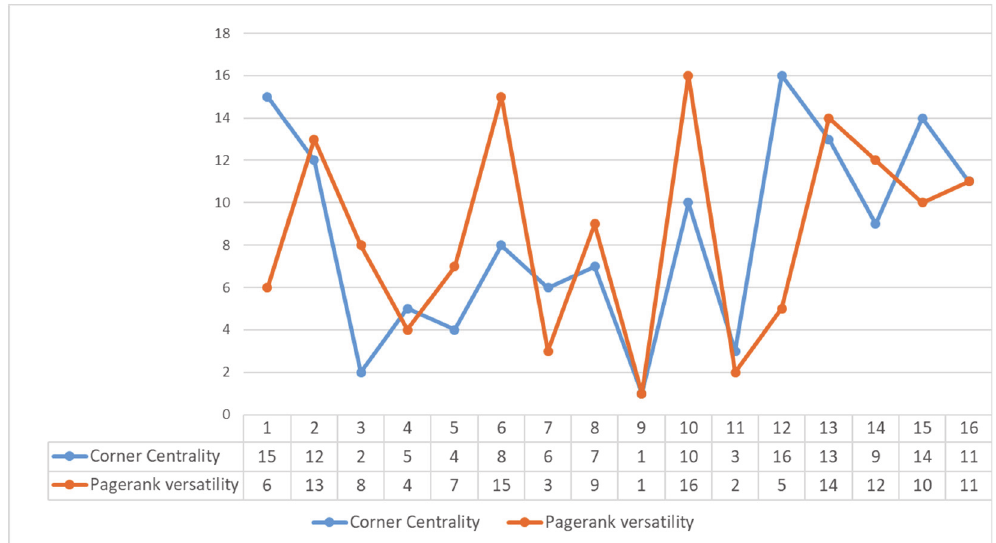
Figure 4. Comparison between Pagerank versality ranking and corner centrality ranking for the Florentine Families multiplex network. In this comparison, we wanted to check the level of consensus between corner centrality and PageRank versatility measures. Both measures selected node 9 as the one with the highest centrality values.